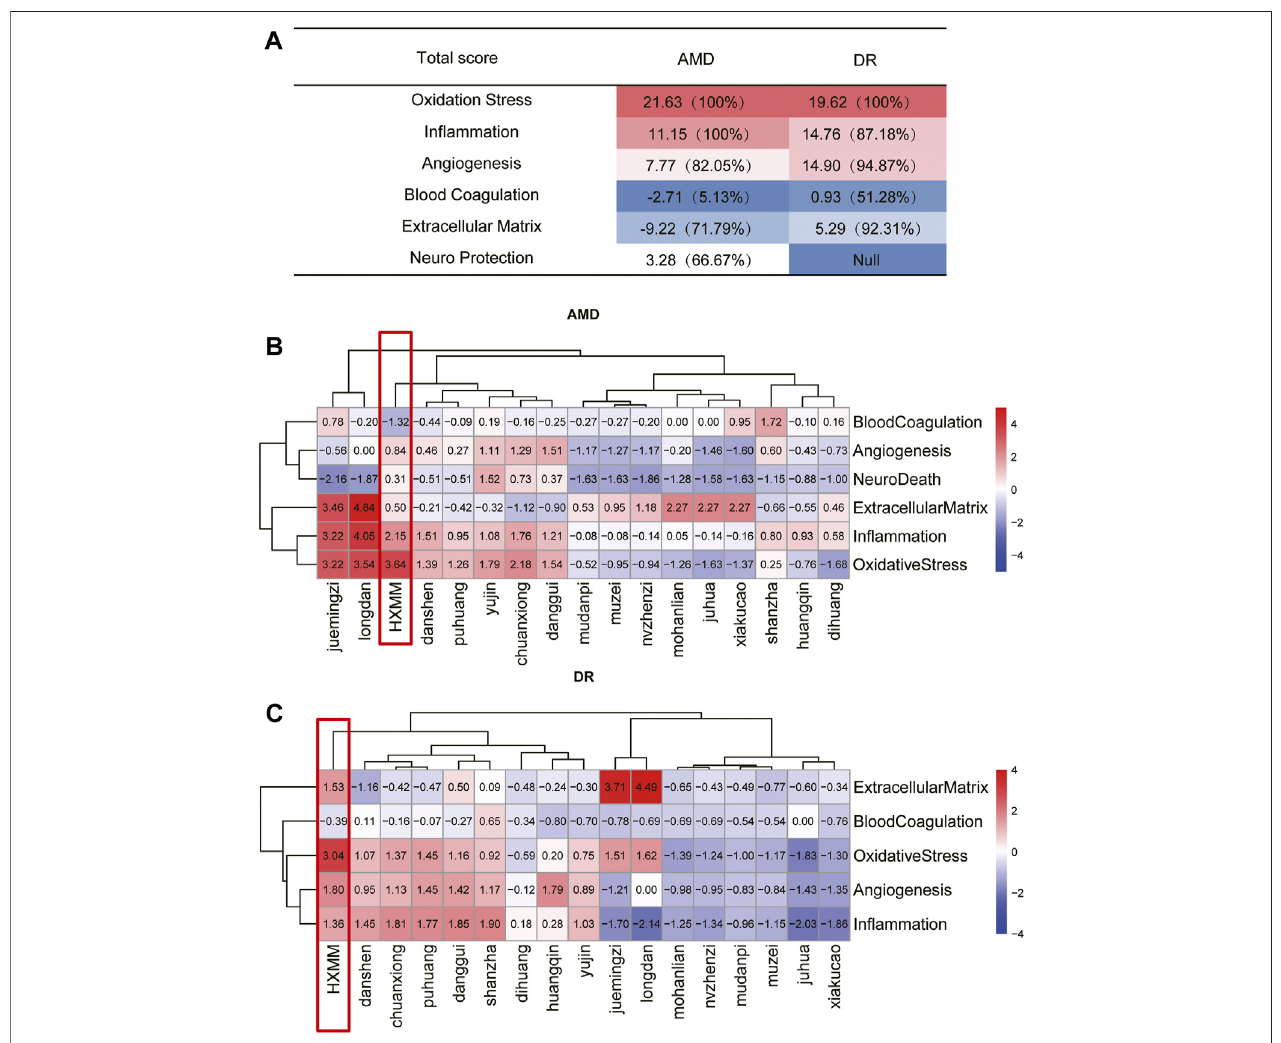
FIGURE 3 | Evaluation of the Robustness of disease network disturbance after multi-target drug attack. (A) Distribution of total scores for different pathological processes in AMD and DR. The scores in brackets indicated the ratio of HXMM total scores greater than those FDA-approved drugs under the same pathological process. (B) Multi-target drug attack prediction on topological scores for AMD. (C) Multi-target drug attack prediction on topological scores for DR. The color depth changed with the increase of the score. The red was a positive number, which represented a stronger positive disturbing effect, and the blue was a negative number,whichmeantthatithadarelativelyweakdisturbingability.Amongthem,HXMMhadshownbetterscoresinmultipleprocesses,especiallyinoxidationstress,so we use the red square to circle it.